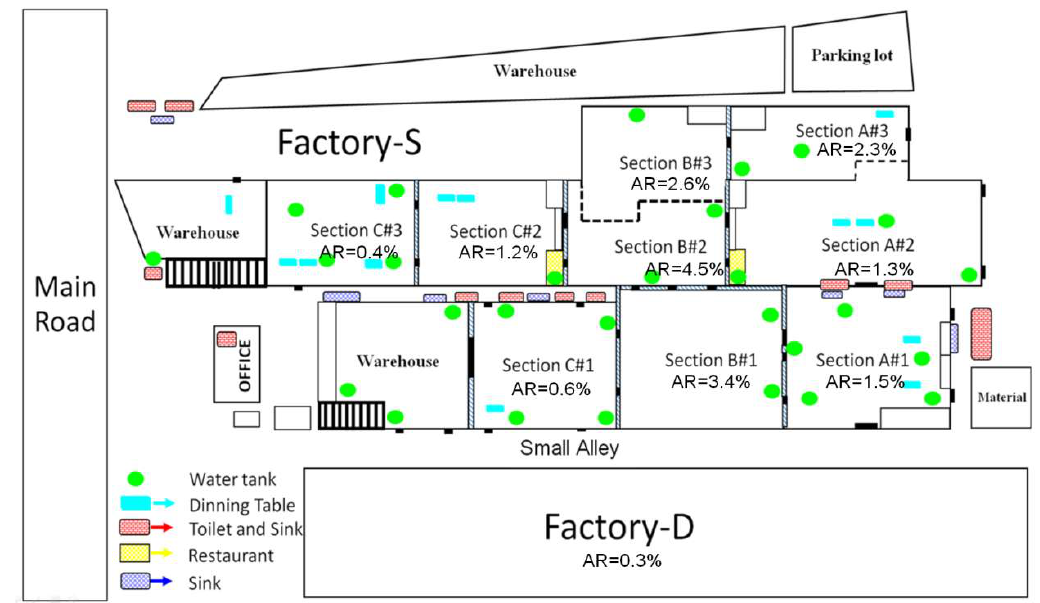
Figure 2. Diagram illustrating the physical structure of Factory-S and Factory-D and attack rate (AR) in each sub section.